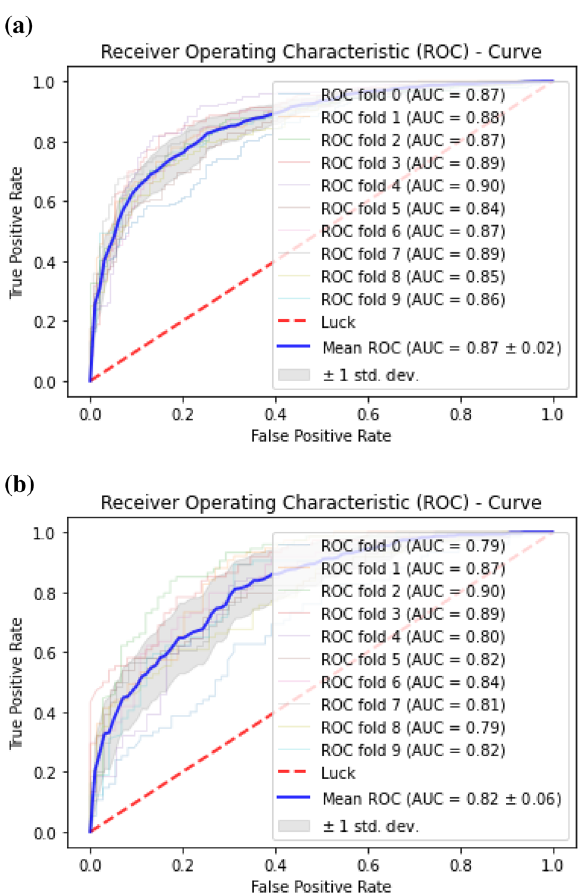
Figure 11. ( a ) ROC curve of tenfold cross validation tests for enhancers using (random forest). ( b ) ROC curve of tenfold cross validation tests for enhancers strength (random